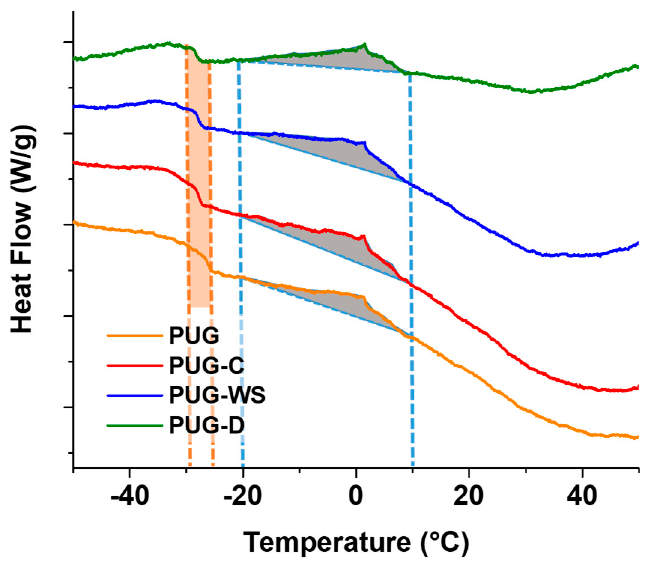
Figure 5. DSC thermograms of produced polyurethane foams. Table 5. Glass Transition Temperatures and Enthalpy values at 0 °C of produced polyurethane foams.